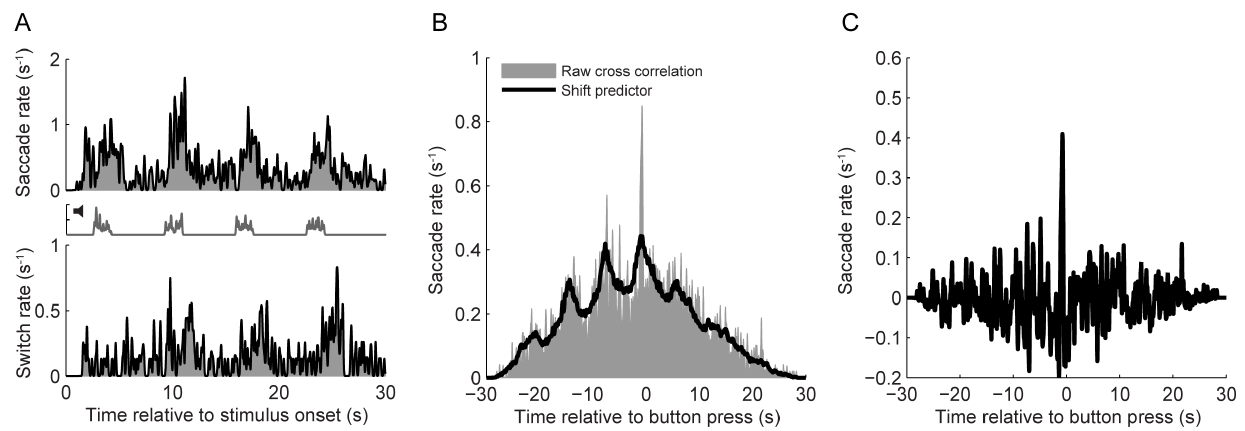
Figure 2. Illustration of the applied cross correlation analysis. A: Peristimulus time histograms (PSTH) showing the average saccade (top) and switch (bottom) rates as a function of time relative to stimulus onset together with PSTHs of the auditory cues (center, gray line). B: Raw cross correlation between saccades and perceptual switches (gray) together with the shift-predictor (black). Data were normalized according to the total number of percept switches such that the vertical axis represents the conditional saccade rate (in saccades per second) as a function of time relative to the button press. C: Covariogram. Corrected cross-correlation histogram obtained by subtracting the shift-predictor from the raw cross correlogram. Data from subject DB. Large saccades ( . 1 u ), percept switches from left to right eye.